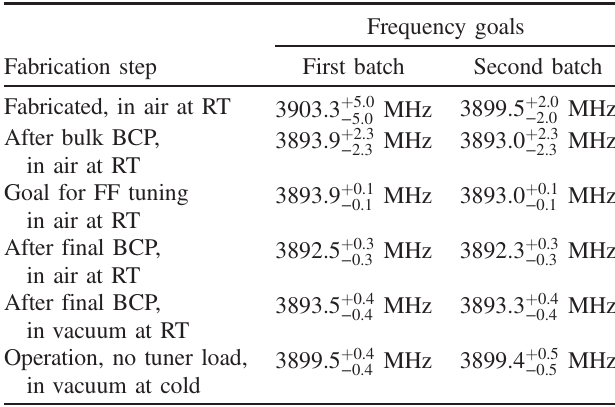
TABLE VI. EXFEL 3.9 GHz cavity frequency preparation goals at intermediate preparation stages and estimated uncertainties.